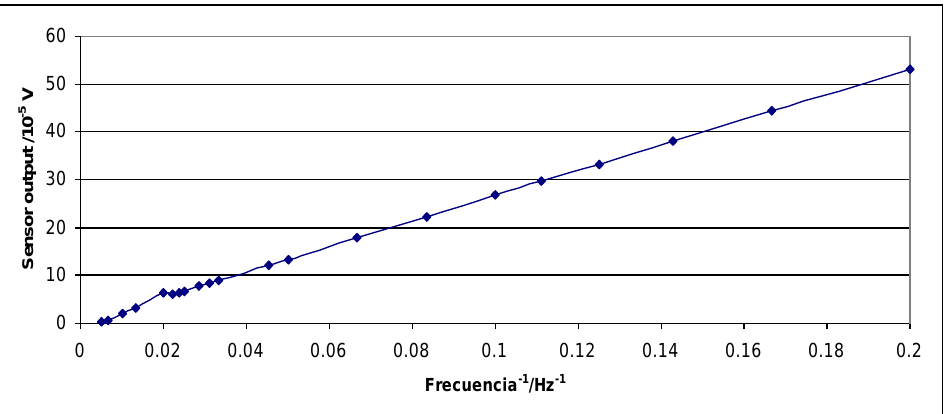
Figure 8. Output for the Interface 1610 sensor, when it was hanging over a magnet attached to the shaker head, versus the inverse of the shaker excitation frequency.